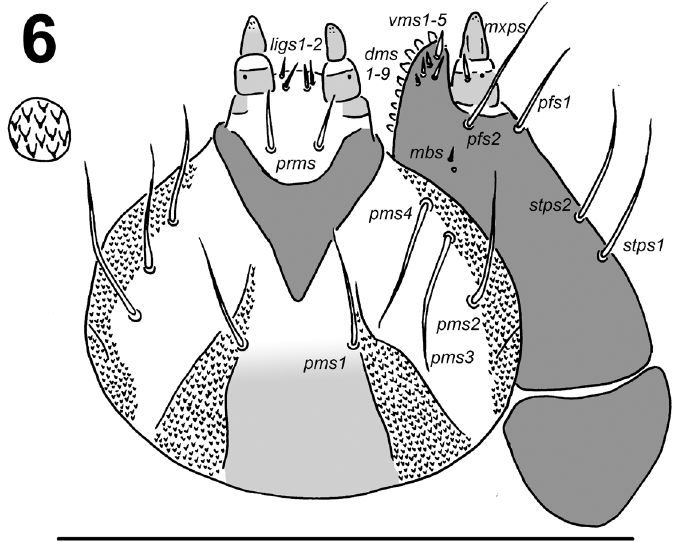
Figure 6. Larinus vulpes larval mouthparts, maxillolabial complex, ventral view: right maxilla. Abbre- viations: dms – dorsal malar s., vms – ventral malar s., mpxs – maxillary palps s., mbs – basioventral s., pfs – palpiferal s., stps – stipital s.), prementum and postmentum, ventral view ( prms – premental s., pms – postmental s., ligs – ligular s.). Scale bar 1